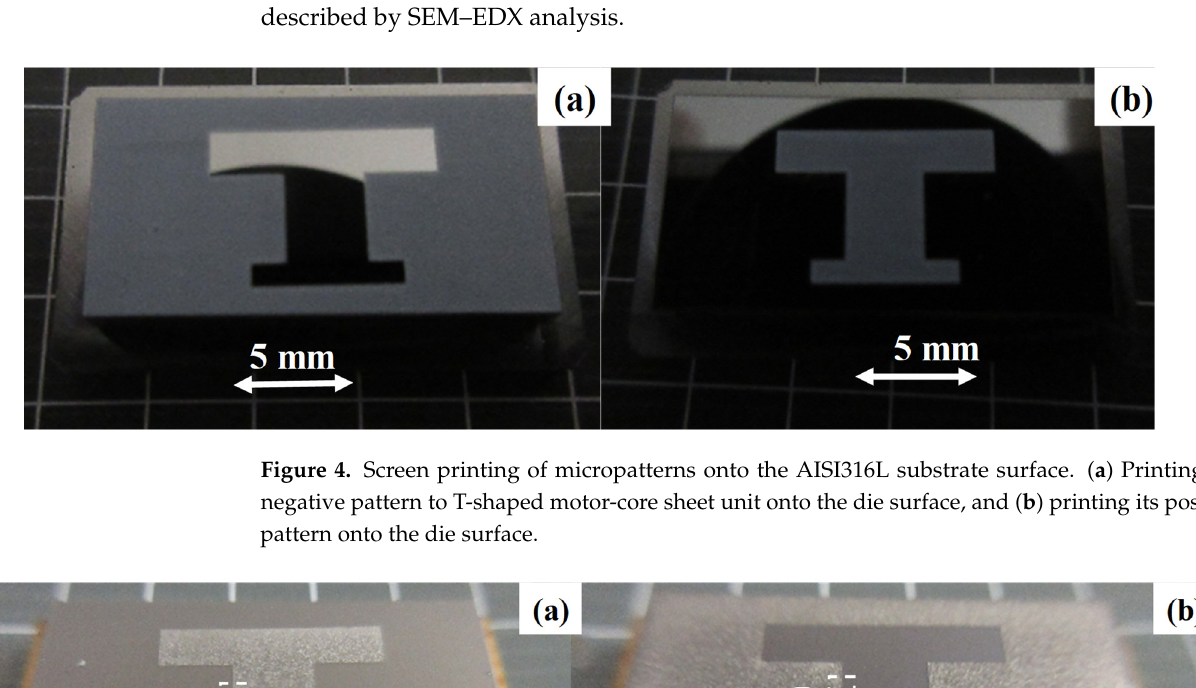
Figure 4. Screen printing of micropatterns onto the AISI316L substrate surface. ( a ) Printing the neg- ative pattern to T-shaped motor-core sheet unit onto the die surface, and ( b ) printing its positive pattern onto the die surface.